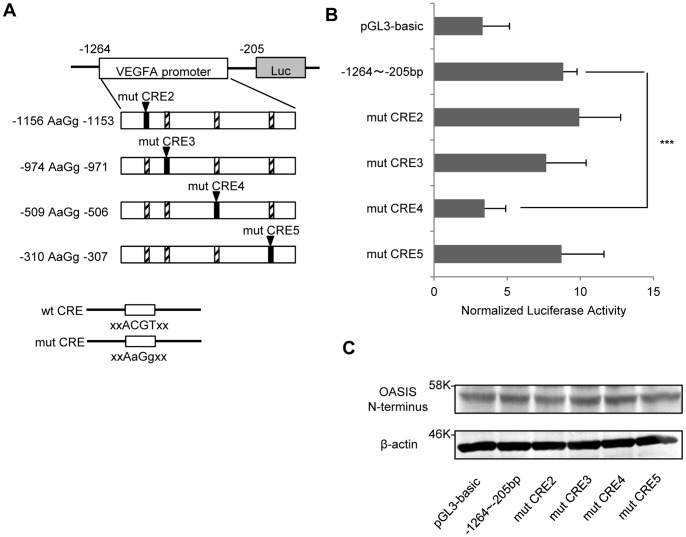
OASIS acts on the CRE-like site at –509 to –506 bp in the VEGFA promoter.(A) The top panel shows schematic diagrams of the mutated reporter constructs. The bottom panel shows schematic representations of the wild-type CRE-like site (containing an ACGT core) and the mutated CRE-like sites (containing an AaGg core). (B) Reporter assays using ARPE-19 cells. Each mutated reporter vector and the OASIS N-terminus expression vector were co-transfected. Reporter assays were performed at 48 h after the transfection. Note that reporter activities significantly decreased in cells transfected with the mutated CRE-like site 4 construct. Data are means ± SD (n = 4). ***p<0.001, by Student’s t-test. (C) Western blot analysis shows the FLAG-tagged OASIS N-terminus was expressed at equal levels in each sample.